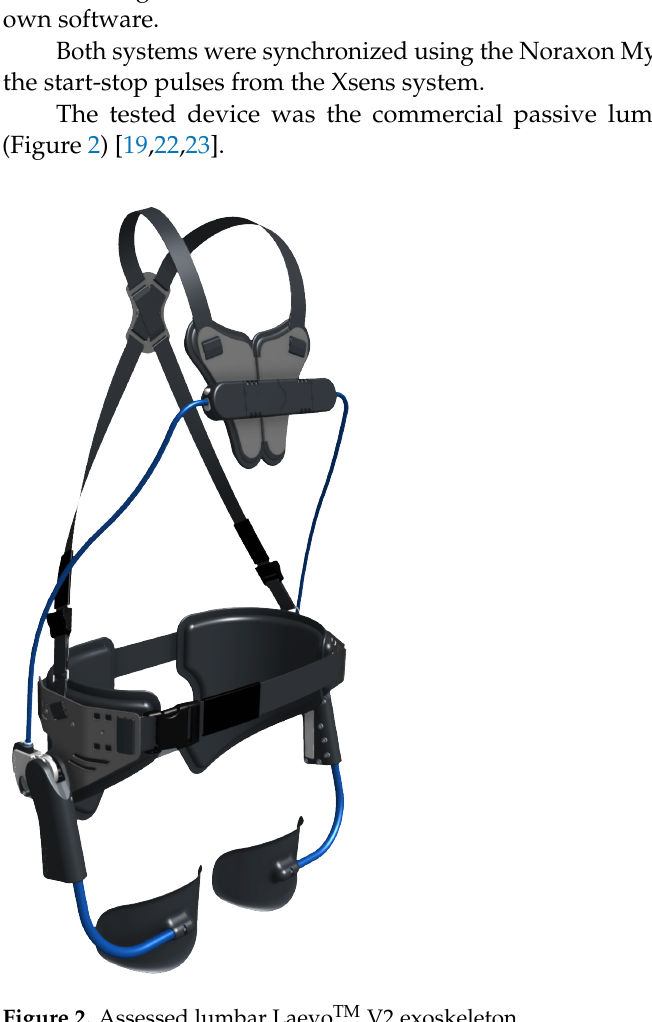
Figure 2. Assessed lumbar Laevo TM V2